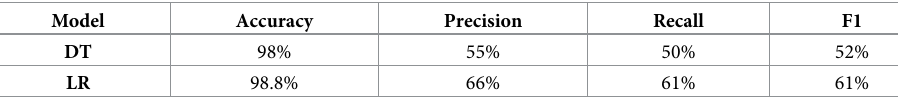
Table 6. Results of testing on the original dataset.